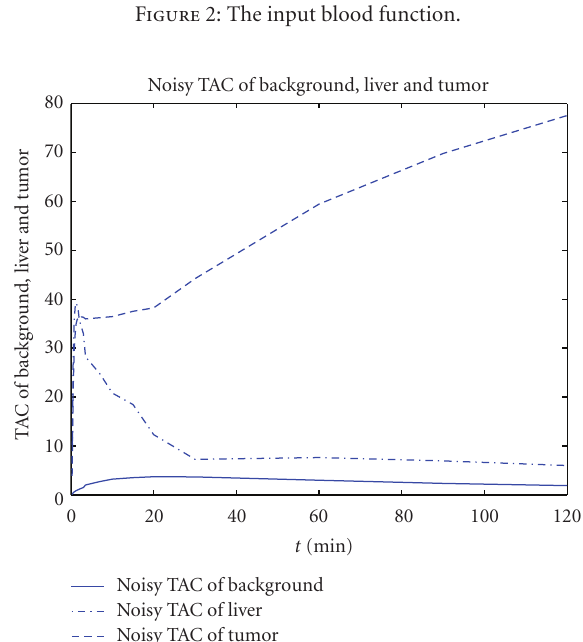
Figure 3: The observed noisy TAC for background, liver, and